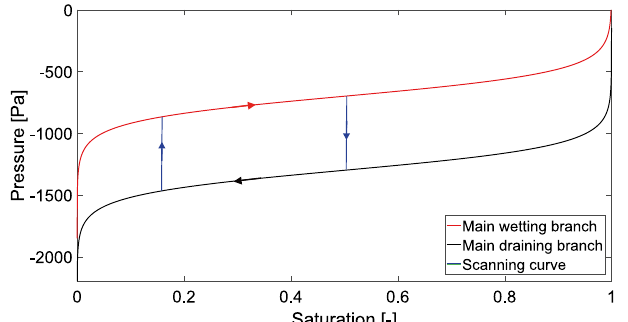
Figure 1. Model of the retention curve hysteresis. The coloured lines correspond to different parts of the retention